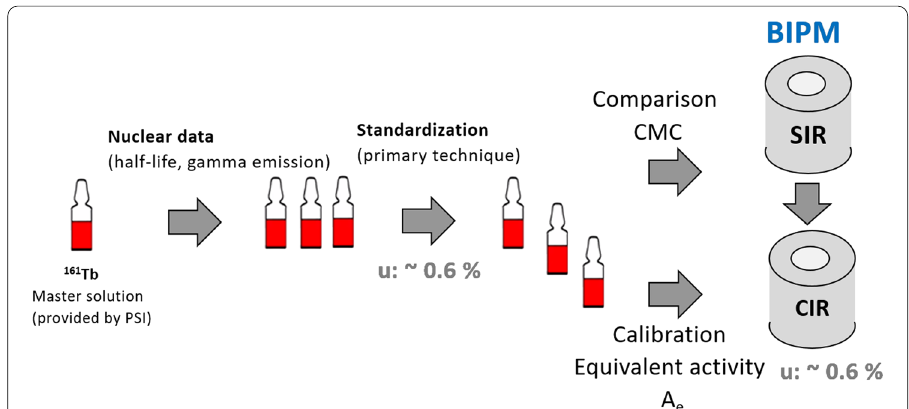
Fig. 2 Scheme of the realization of a 161 Tb standard ( CMC Calibration and Measurement Capabilities, BIMP The Bureau of Weights and Measures, SIR Système International de Référence, CIR Chambre d’Ionisation de